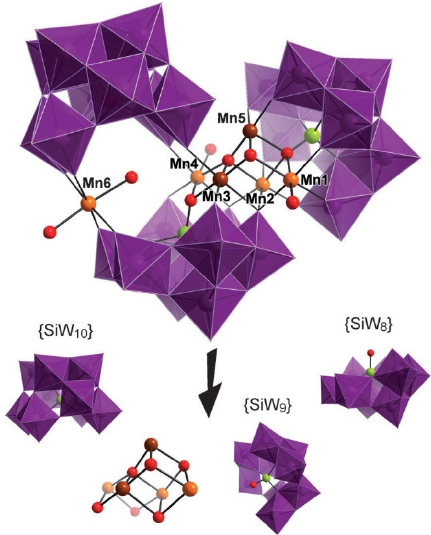
Figure 2. Structure of Mn 6 SiW; WO 6 polyhedra, purple; Mn, orange and brown; Si, green and O, red [33]. Reprinted with permission from ref. [33]. Copyright 2011 John Wiley and